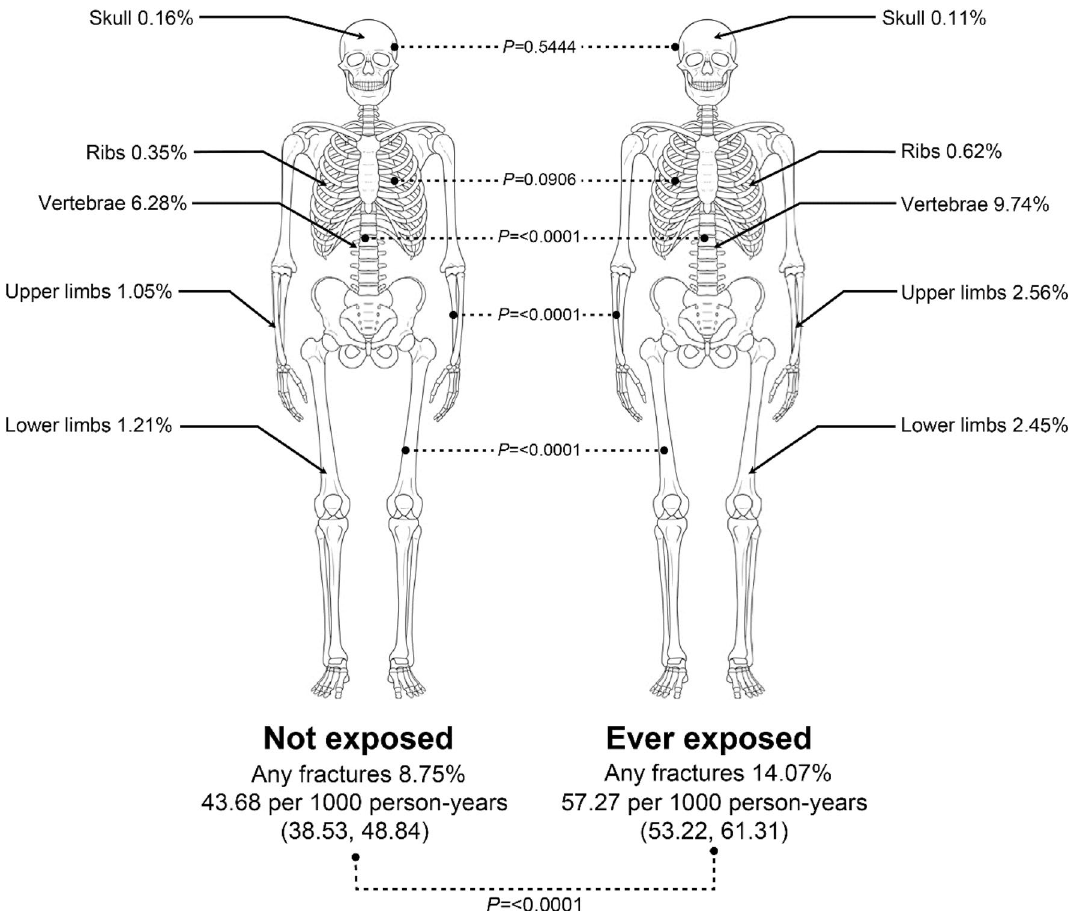
Figure 2. Comparison of fracture outcomes (including skull, ribs, vertebral, upper limb, and lower limb fractures) between the unexposed and exposed groups. The P-value calculated from the Chi-square test for independence is